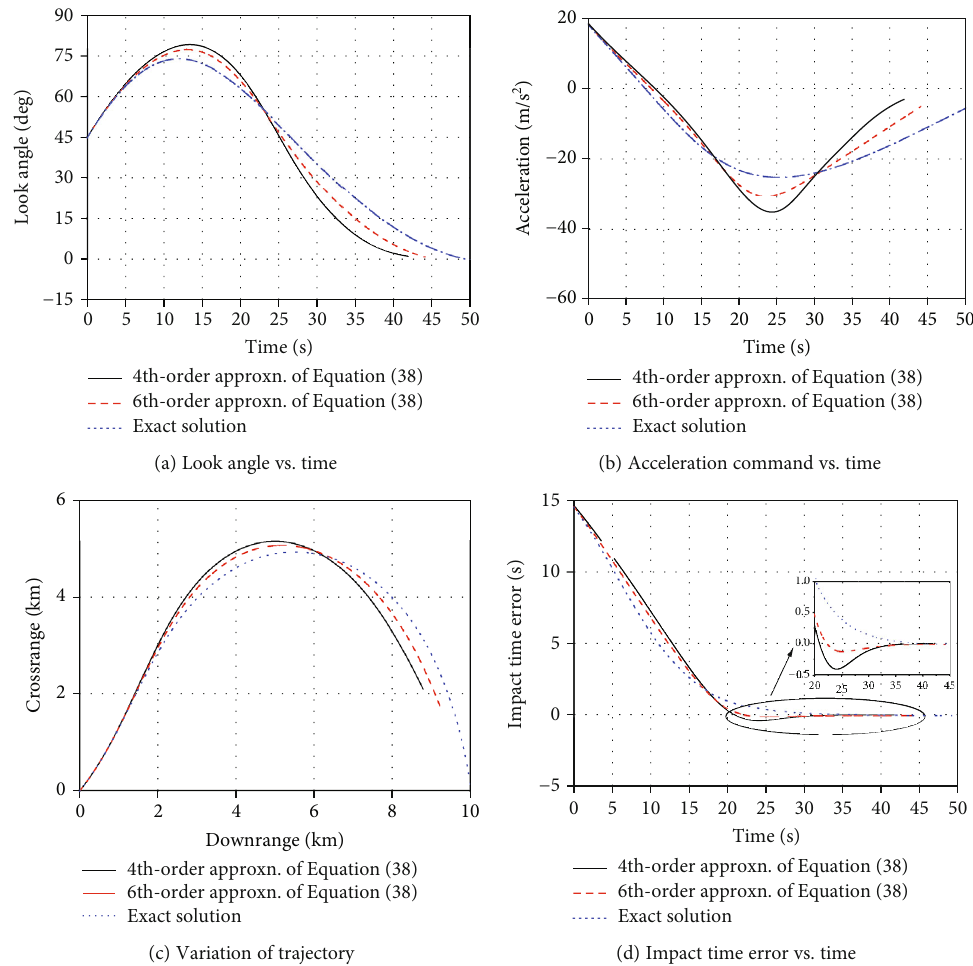
Figure 3: Results of ITCG law of [6] using di ff erent time-to-go estimation